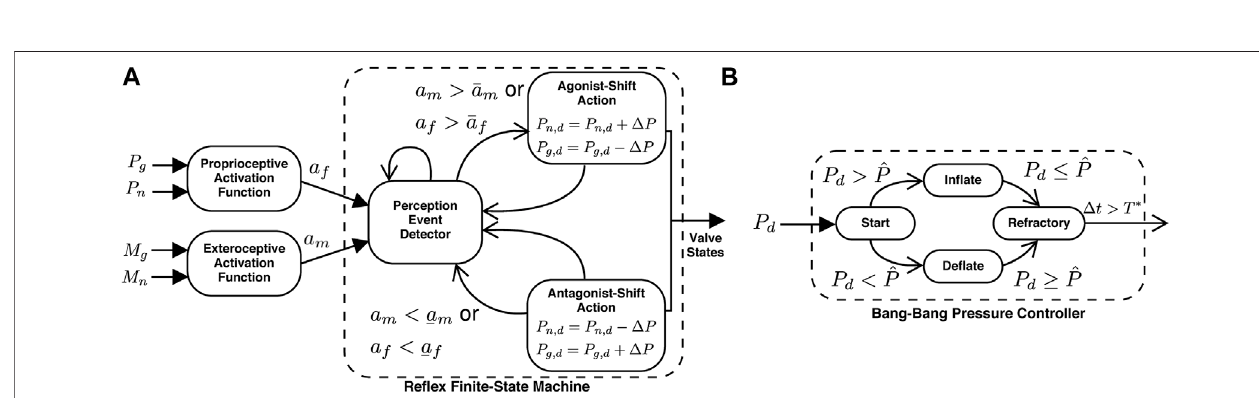
FIGURE 3 | | Schematic representation of the equilibrium-point controller consists of the re fl ex and bang – bang fi nite-state machines. (A) The re fl ex fi nite-state machine triggers theappropriate action basedon the outputs oftheactivation functions. Theproprioceptiveinputs include the internal pressure ofthe actuators ( P g and P n ) and are processed by the proprioceptive activation function ( Eq. 1 ). The exteroceptive inputs include the biological muscle sEMG signals ( M g and M n ), which are processed with the exteroceptive activation function ( Eq. 2 ). The re fl ex fi nite-state machine consists of the perception-state (event detector) and the two possible action states (either agonist- or antagonist-shift). The action states, triggered via threshold crossings, set the desired pressures which are then achieved via the bang – bang controller. Onceanaction iscompleted, therobot returns tothe perception state. (B) Thebang – bang pressurecontroller setsthevalvecon fi gurations. Ifthe internal pressure of the actuator ^ P (subscripts dropped for convenience) is less than the desired pressure P d , then the actuator is in fl ated. If the ^ P is greater than the desired pressure P d , the actuator is de fl ated. After the internal pressure has been achieved, there is a refractory period T * before returning to the perception state.